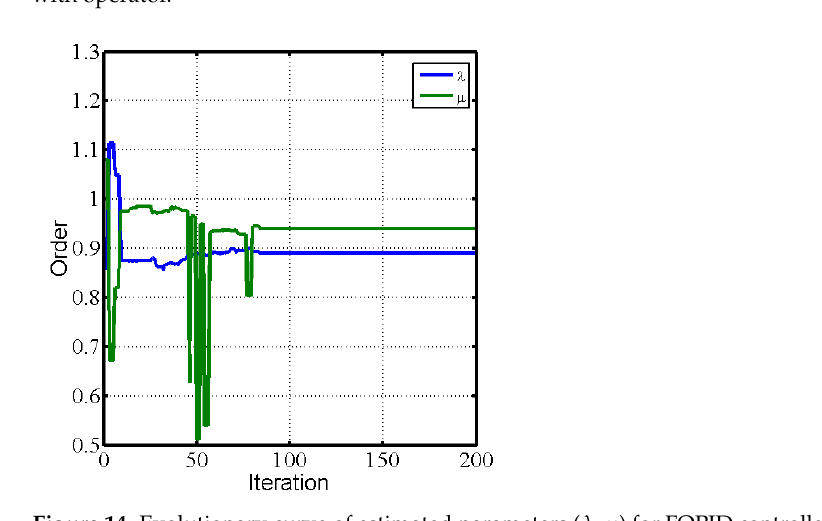
Figure 14. Evolutionary curve of estimated parameters ( λ , µ ) for FOPID controller with operator.